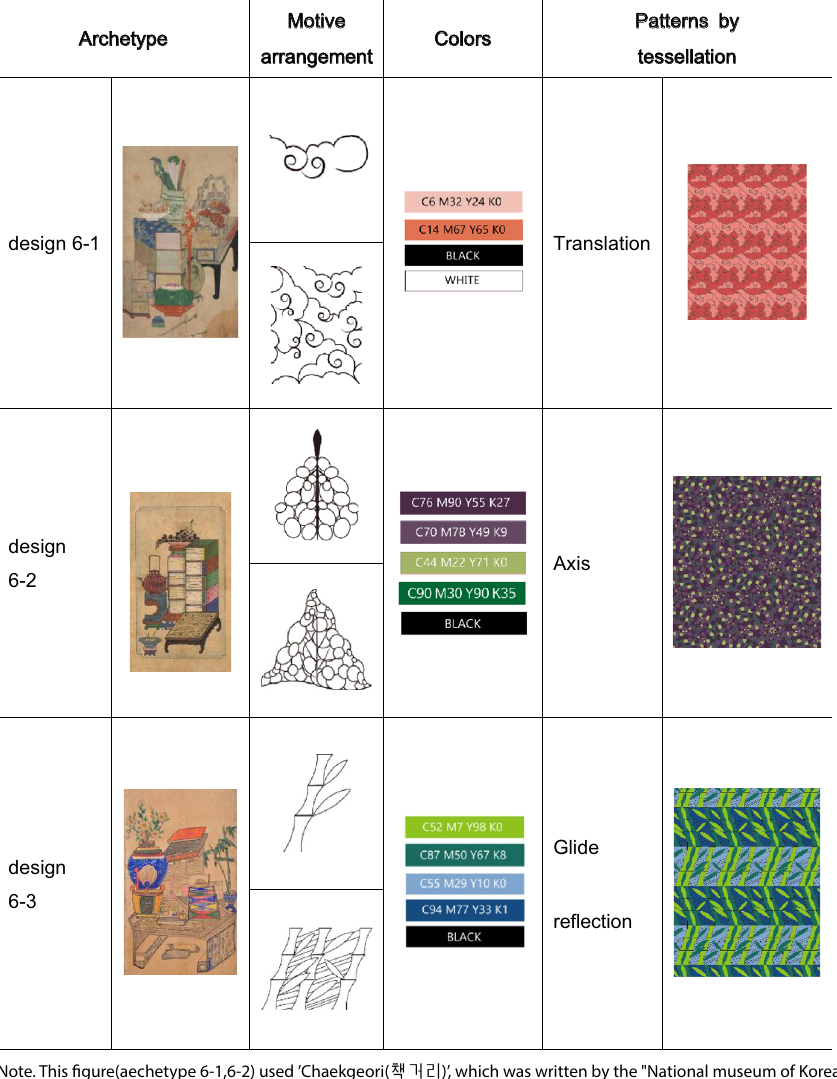
Table 6 Textile pattern design using health